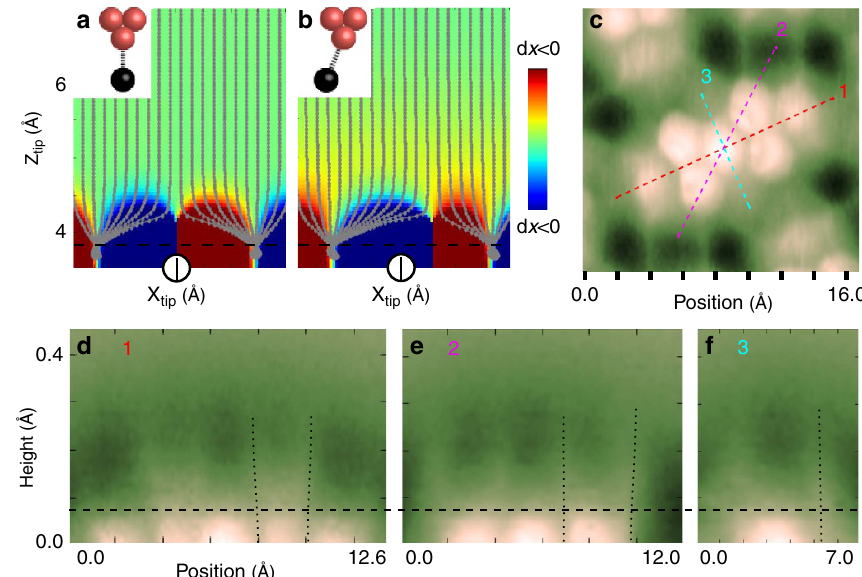
Figure 2 | Height dependence of the position of the sharp edges in AFM images. ( a ) Simulated deflections of the probe particle as a function of tip position. Grey lines represent the additional deflection of the probe particle with respect to its optimal configuration in far distance. The deflection of the probe particle to the left and right is indicated by blue and red, respectively. ( b ) Same as a but now in the presence of an additional constant lateral force (see Supplementary Fig. 2 and Supplementary Note 2 for more details). ( c ) Constant-height AFM image of PTCDA on Ag(111). Dashed lines with numbers 1,2,3 denote positions of different vertical cut planes. ( d – f ) Evolution of D f with height along the lines shown in c . The black dotted lines guide the eye to see relevant edges. The horizontal dashed line indicates the approximate z -distance of contrast